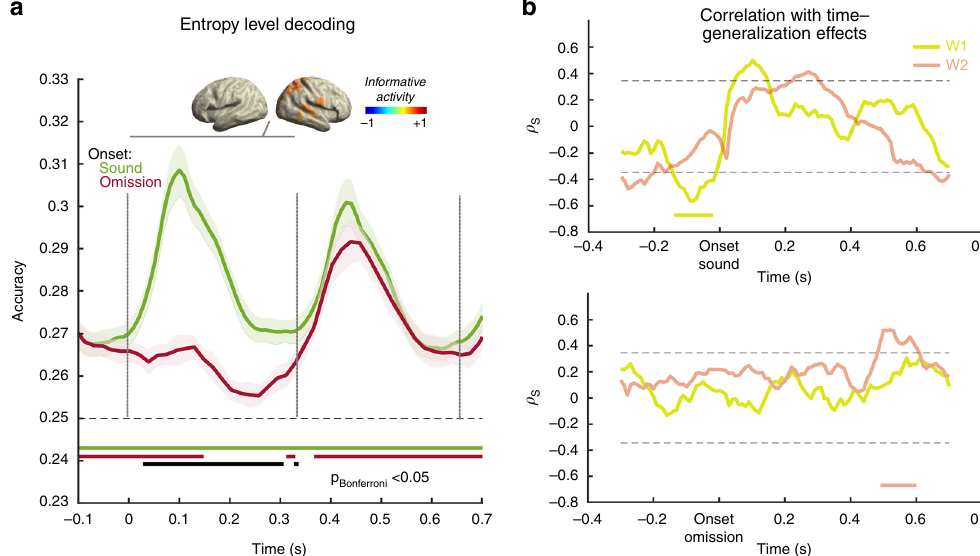
Fig. 4 Decoding entropy level of sound sequence and correlation main prediction effects gained from time-generalization analysis (see Fig. 3). a A classi fi er was trained to decode the entropy level from MEG activity elicited by sounds and tested around relevant events, i.e. sound or omission onset. Robust increases of decoding accuracy can be observed following sound onsets. Right temporal and parietal regions appear to contribute most informative activity (small inset, relative change baseline (-100-0 ms), 50% threshold). While overall decoding accuracy is above chance level throughout most of the entire period, this pattern breaks down brie fl y following an omission. b Average entropy level decoding following sound onset (0 – 330 ms) was taken and (Spearman) correlated with the time-generalized decoding accuracy of the low entropy condition. Nonparametric cluster permutation test yields a signi fi cant negative correlation especially with early training time-window patterns (W1) in the anticipation period towards a sound that was; however, not observed prior to omissions. Following the onset of omissions nonparametric cluster permutation testing pointed to a late positive correlation with the